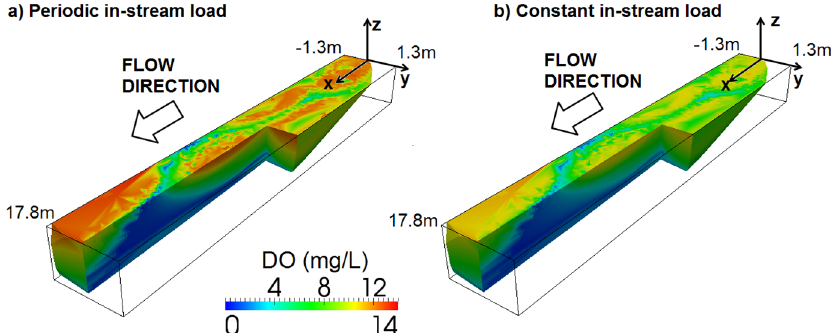
Figure 8. Maps of dissolved oxygen concentrations, DO, within the hyporheic zone for ( a ) periodic and ( b ) constant in-stream concentrations of DO, CBOD and NBOD. In both cases, R DO = 1.2 and R BN = 0.5 (Test 5-A), with R DO the ratio between in-stream DO ( DO 0 ) and total oxygen demand ( L 0 C + L 0 N ) and R BN the ratio between in-stream carbonaceous and nitrogenous BOD concentrations, R BN = L 0C /L 0N